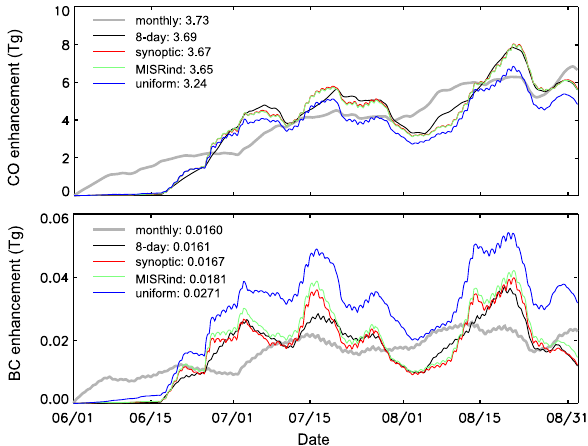
Fig. 8. Time series of enhanced total CO and BC burdens (Tg) in North America (180W–60W, 30N–80N) for June–August 2004. The enhancement is the difference between simulated CO/BC bur- den and that from the nobbNA simulation. The 3-month mean val- ues for the enhancement from each simulation are shown in the leg-